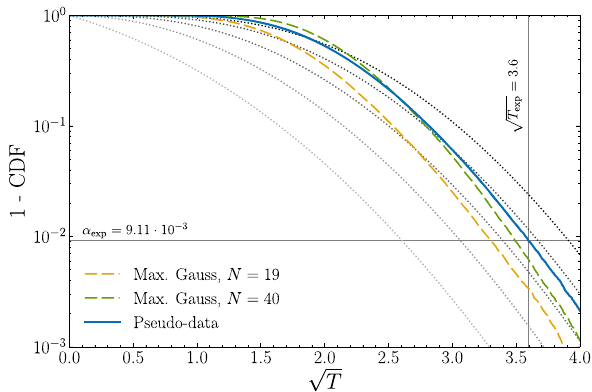
√ T for √ Fig. 6 Confidenceregionsfromourre-analysisofNeutrino-4data[30] T = 3 . 6 at 68.3% (dark green), 95.45% (medium green), and 99.73% CL (light green).Shadedregionscorrespondtotheconfidenceregionsconstructed by Monte-Carlo simulations following the Feldman–Cousins prescrip- tion [31], whereas black curves show the corresponding CL contours in Δχ 2 assumingitfollowsa χ 2 -distributionfor2DOF,thatis, Δχ 2 = 2 . 3 (solid), 6.18 (dashed), 11.83